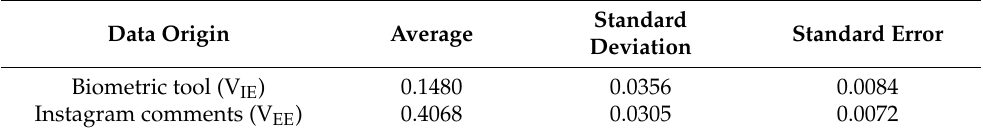
Table 5. Statistical results of emotional